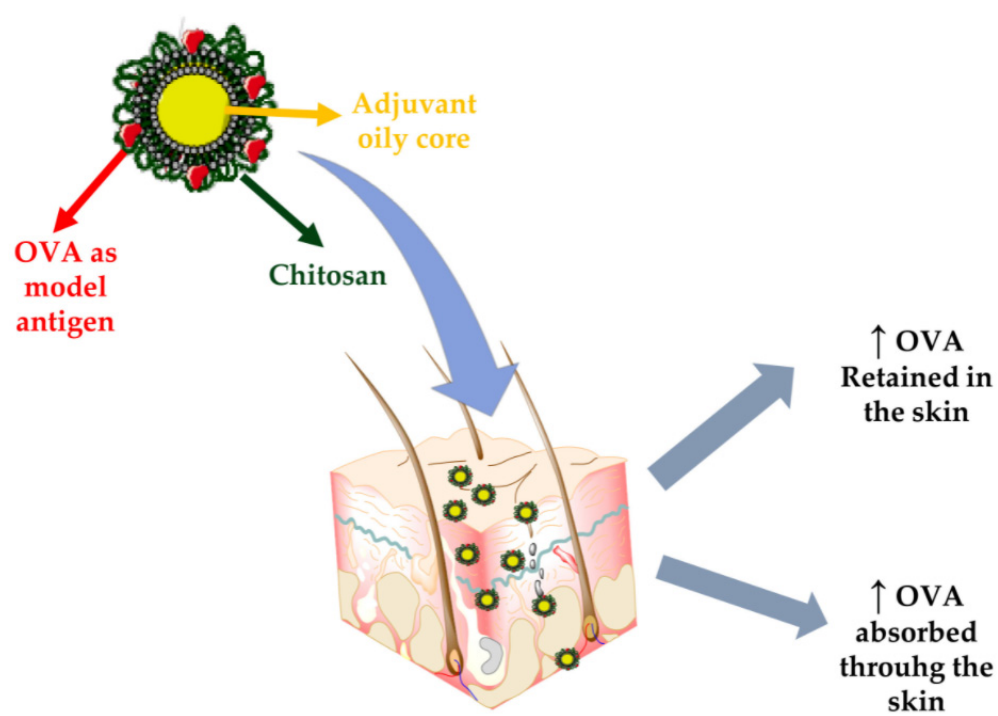
Figure 10. Schematic representation of chitosan-based nanocapsules for transcutaneous antigen delivery. Reprinted from an open-access source [321].